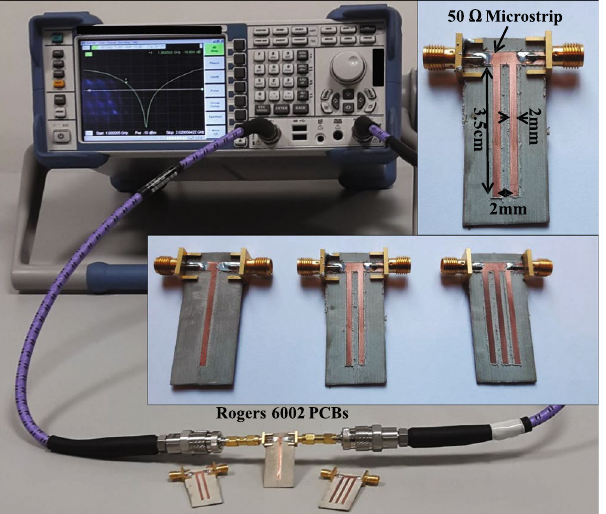
Figure 13. Experimental setup for the characterization of scattering parameters for the microstrip